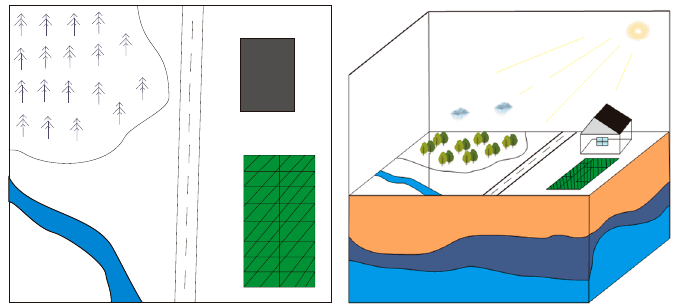
Figure 1. Different presentations of land and land space.